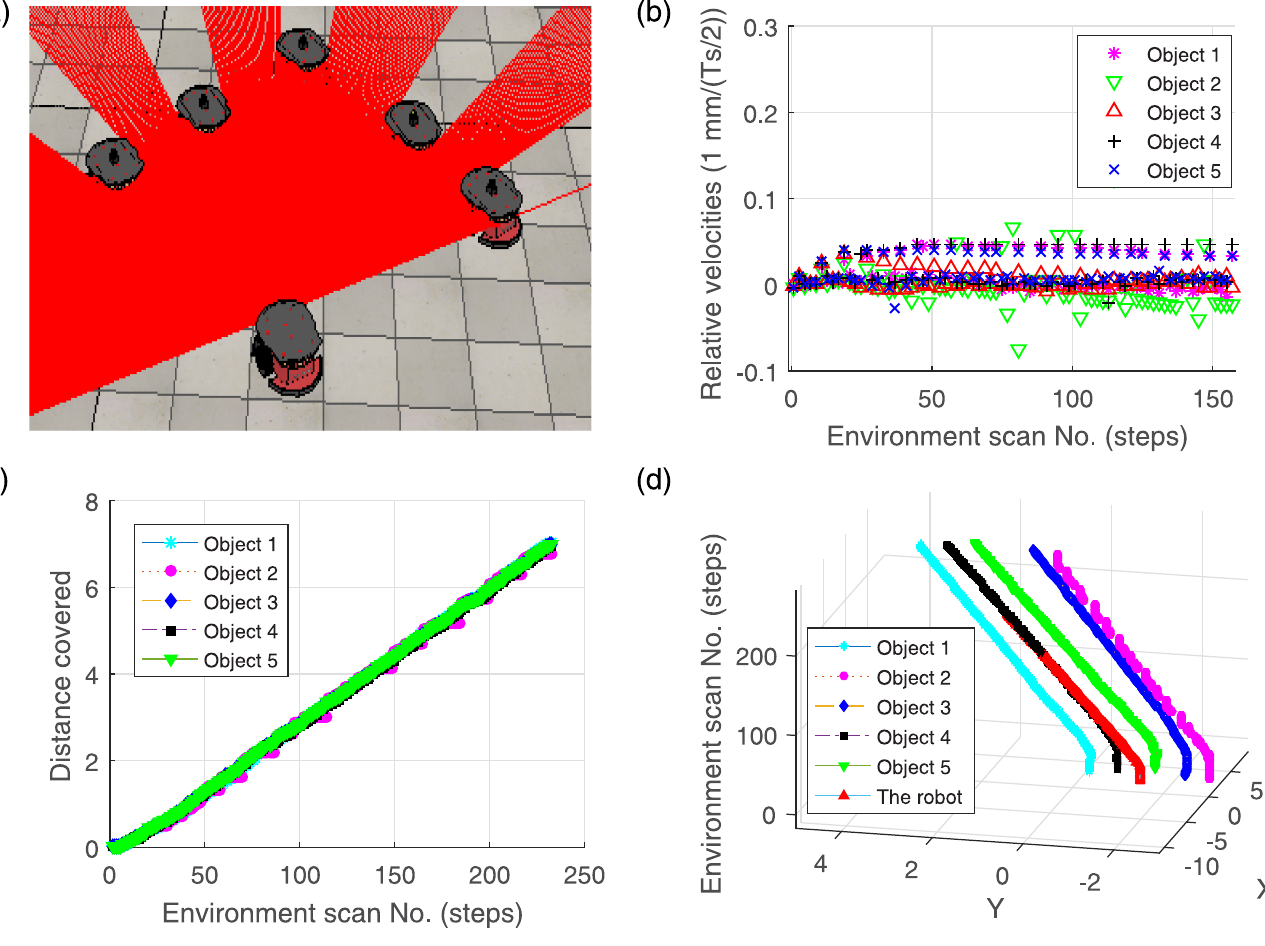
Fig 6. Validation results in the case of birds flock